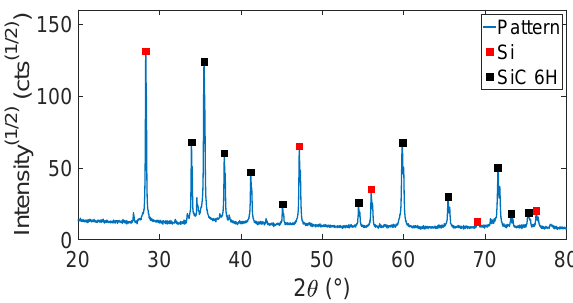
Figure 13. XRD spectrum of the densified Si-SiC material, with peaks corresponding to Si (red) and SiC